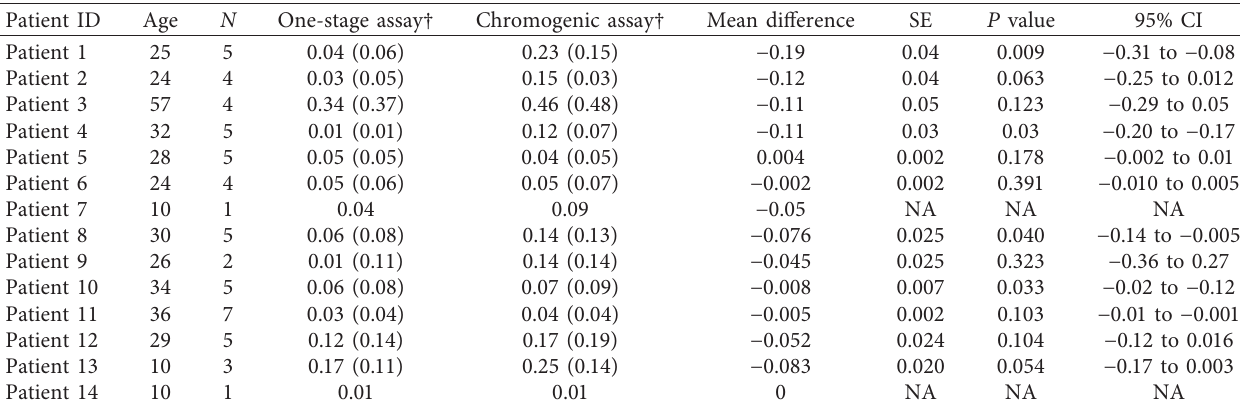
Table 2: The comparison between the one-stage assay versus chromogenic assay for the measurement of factor VIII levels in the individual